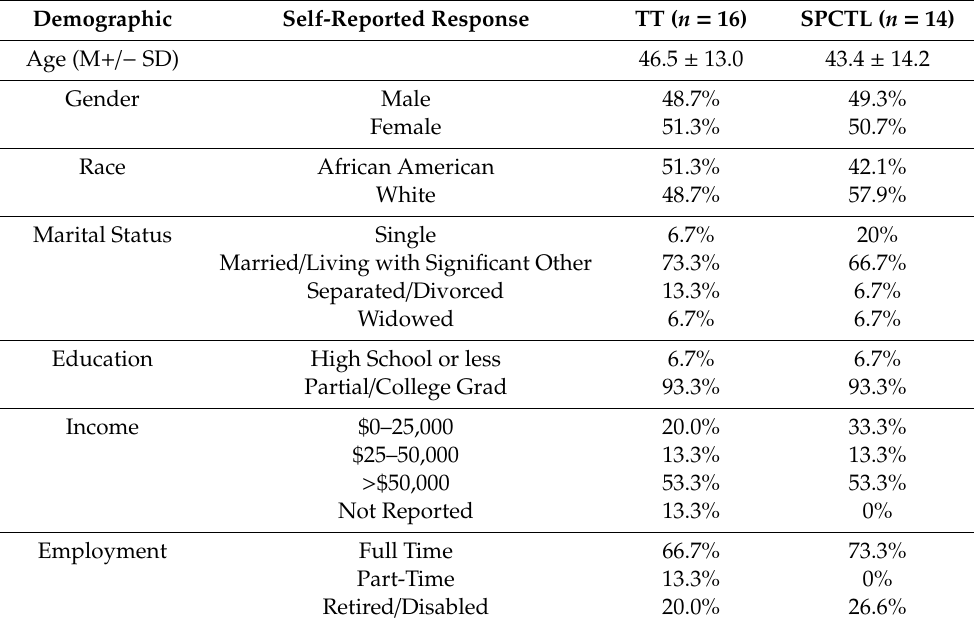
Table 1. Descriptive characteristics of participants ( n = 30). TT, Tension Tamer; SPCTL, lifestyle education program delivered via